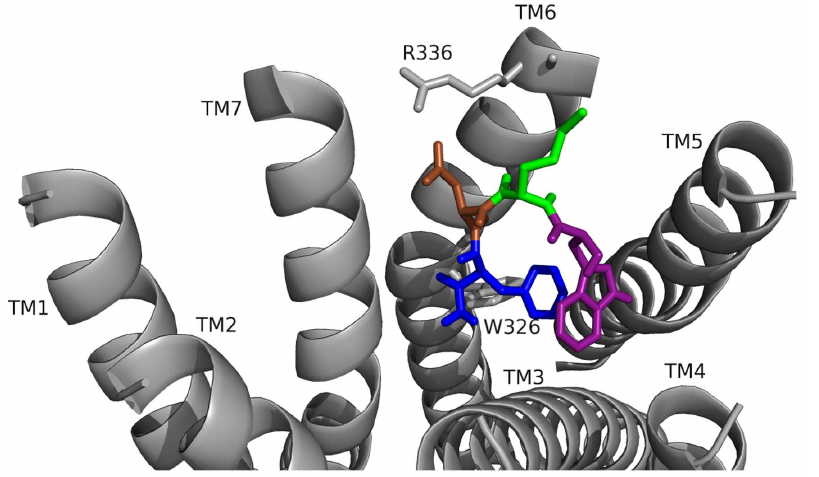
Figure 1. WMDF-NH 2 docked to CCK-R1. Contacts between the amino acids inWMDF-NH 2 are shown as W (purple), M (green), D (brown), and F (dark blue) and the receptor, FMRFa-R, whose transmembrane regions are labeled TM # where # is 1–7. The C-terminal F was amidated, -NH 2 .